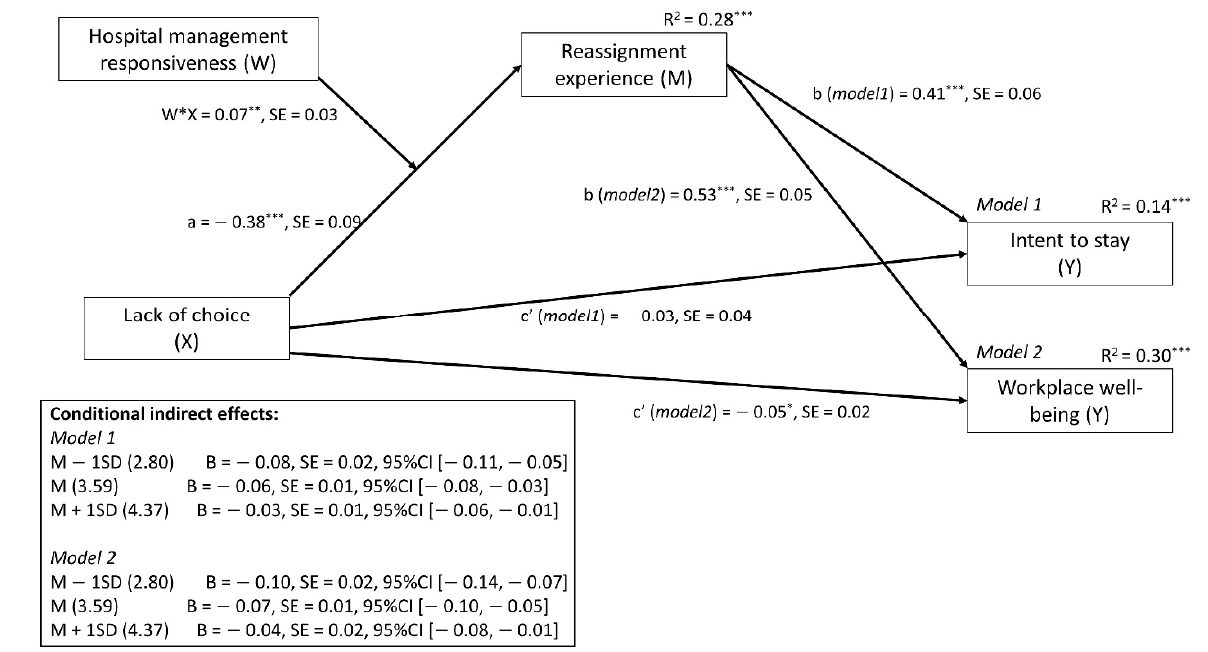
Figure 2. Final model showing moderated mediation. Effect of lack of choice on intent to stay (model 1) and well-being (model 2) is mediated by reassignment experience, and this effect is conditioned (moderated) by hospital management responsiveness. Note: *** p < 0.001; ** p < 0.01; * p < 0.05.